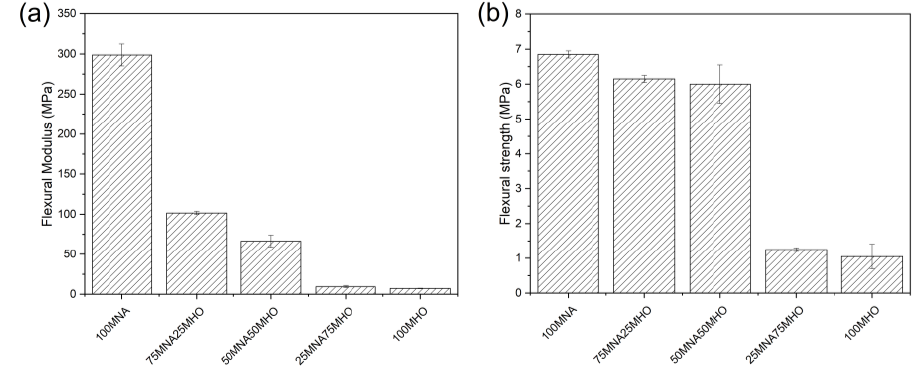
Figure 9. Results of flexural test on epoxidized hemp oil (MHO) crosslinking with different percentages of maleinized hemp oil and methyl nadic anhydride (MNA) ( a ) flexural modulus and ( b ) flexural strength.